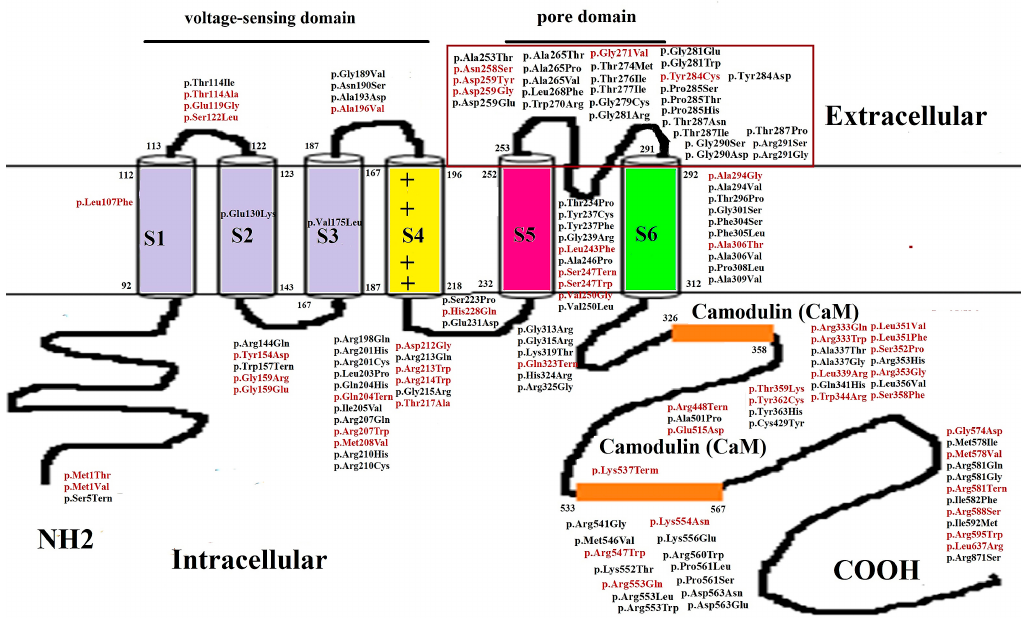
Figure 1. Mutations of KCNQ2 are demonstrated in corresponding to KCNQ2 functional domains. Mutations with red fonts indicate the phenotype of BFNCs; mutations with black fonts are KCNQ2 EE. Twenty-eight mutations (within the brown square) are in the SF domain of KCNQ2 . Five mutations highlighted in red (17.9%) indicate those causing benign familial neonatal convulsions; 23 mutations highlighted in black (82.1%) indicate those causing epileptic encephalopathy.